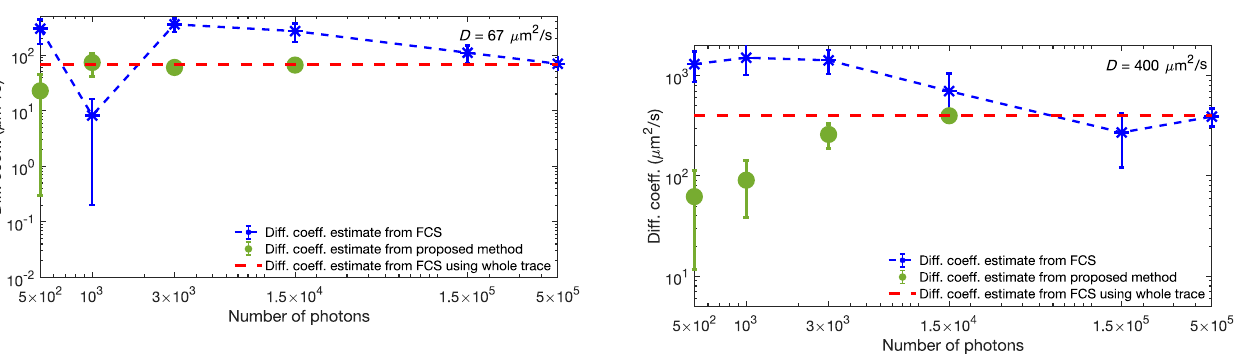
FIG. 13. Diffusion-coefficient estimates of 5-TAMRA dye. Estimates shown are drawn from experimental traces with fixed concentration 20 nM of 5-TAMRA dye molecules. Similarly to Fig. 1, we compare our method ’ s diffusion-coefficient estimate (green dots) to FCS (blue asterisk) as a function of the number of photons used in the analysis. Since by 1 . 5 × 10 4 photon arrivals our method has converged, we avoid analyzing larger traces. The red dashed line is the FCS estimate obtained from the entire, 10-min, trace containing ≈ 6 × 10 6 photon arrivals.